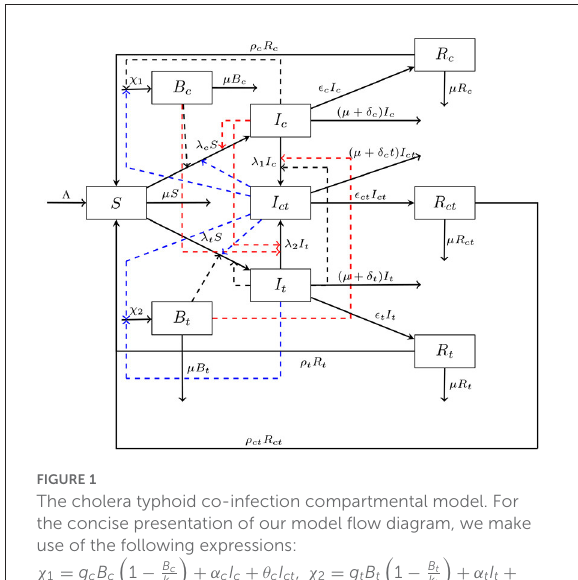
FIGURE1 The cholera typhoid co-infection compartmental model.